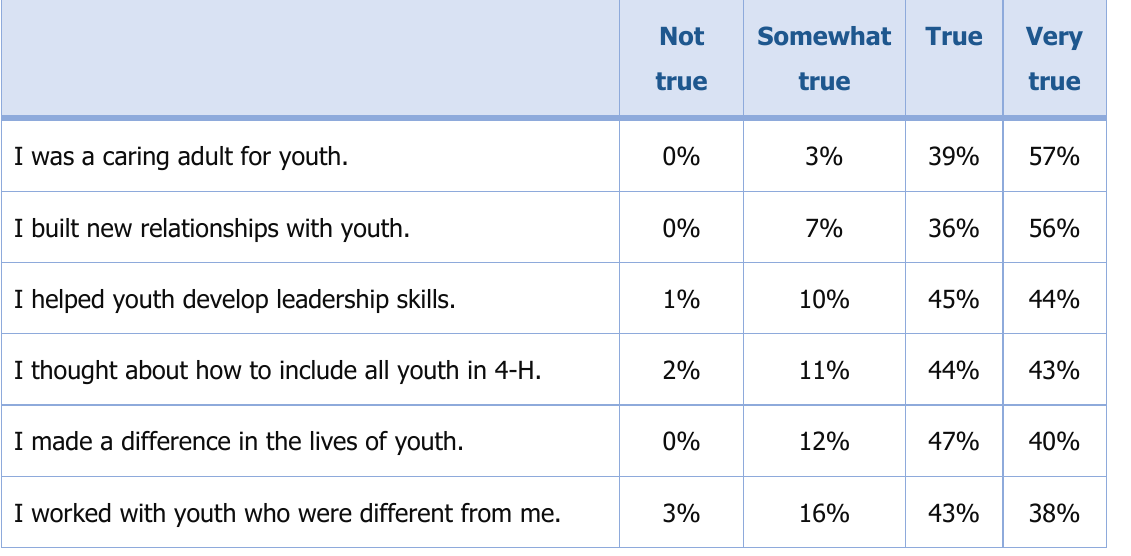
Not Somewhat True Very true